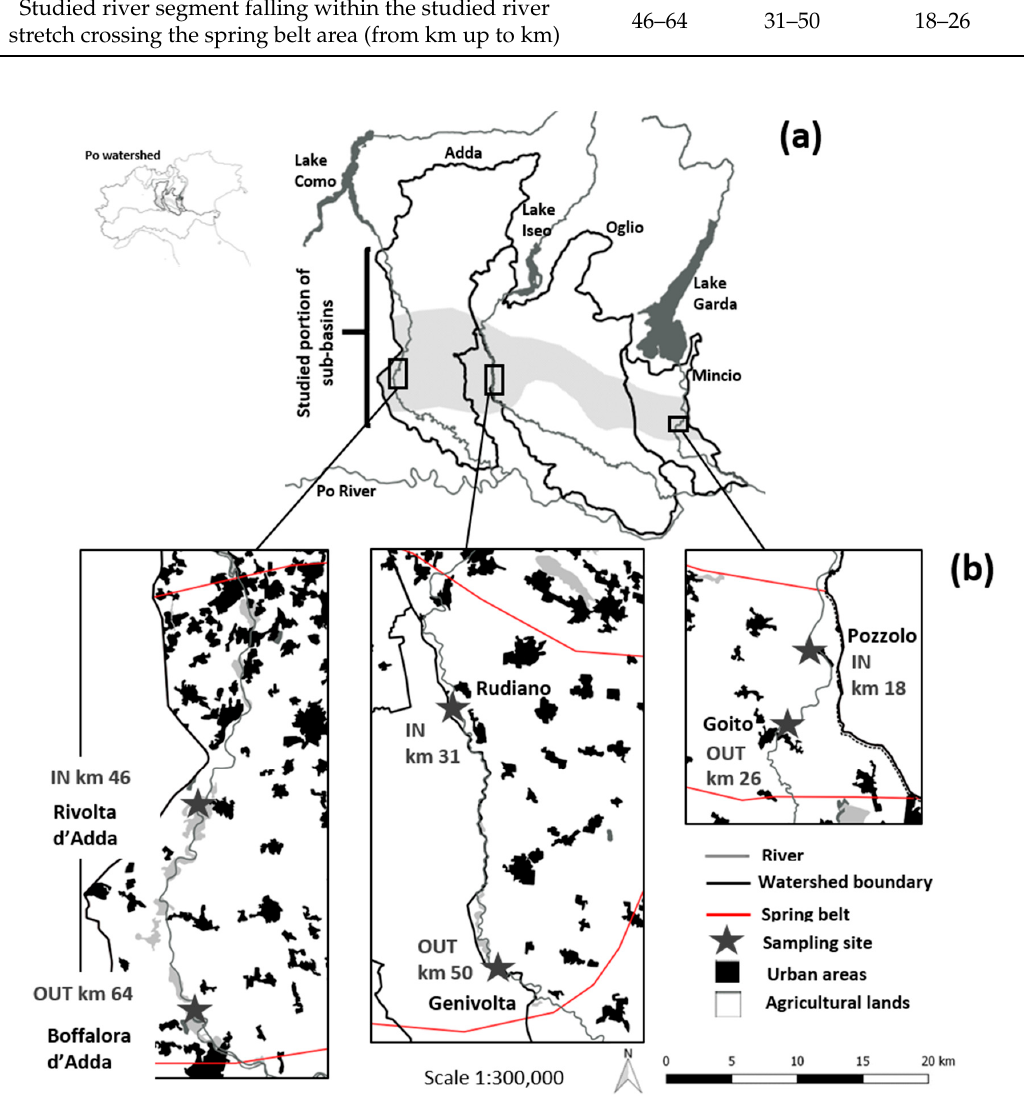
Figure 1. Oglio and Mincio sub-basins of the Po watershed, northern Italy, with the spring belt area indicated in grey ( a ) Lower panels report the studied reaches, corresponding to the initial 70, 60, and 40 km of the three rivers, respectively ( b ) N mass budgets were performed with repeated flow measurements and water analyses at IN and OUT stations.